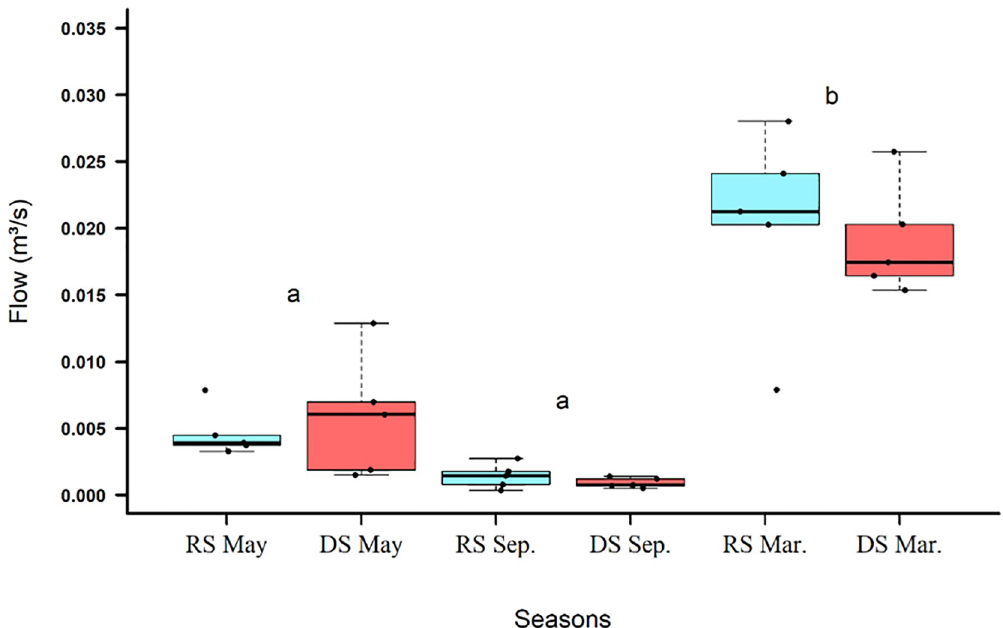
Fig 3. Box-plot graphs with data from flow (m 3 /s) over a hydrological year (May/19, September/19 and March/20) of the reference stream (RS) and the degraded stream (DS) in Catal ã o, GO, Brazil.